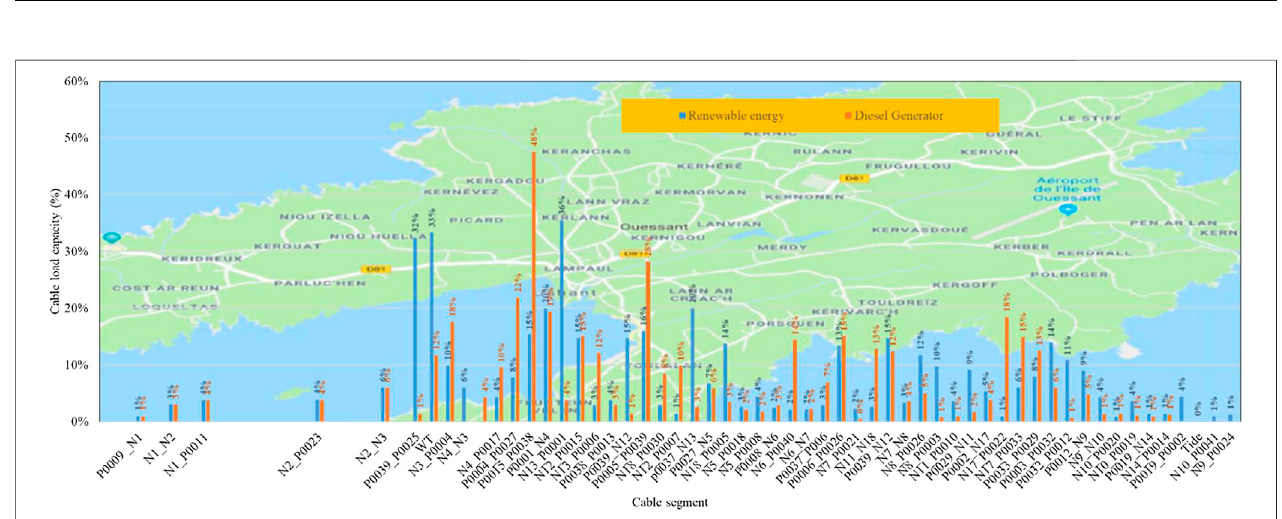
FIGURE 18 | Cable capacity usage under renewable energy sources and diesel generators.